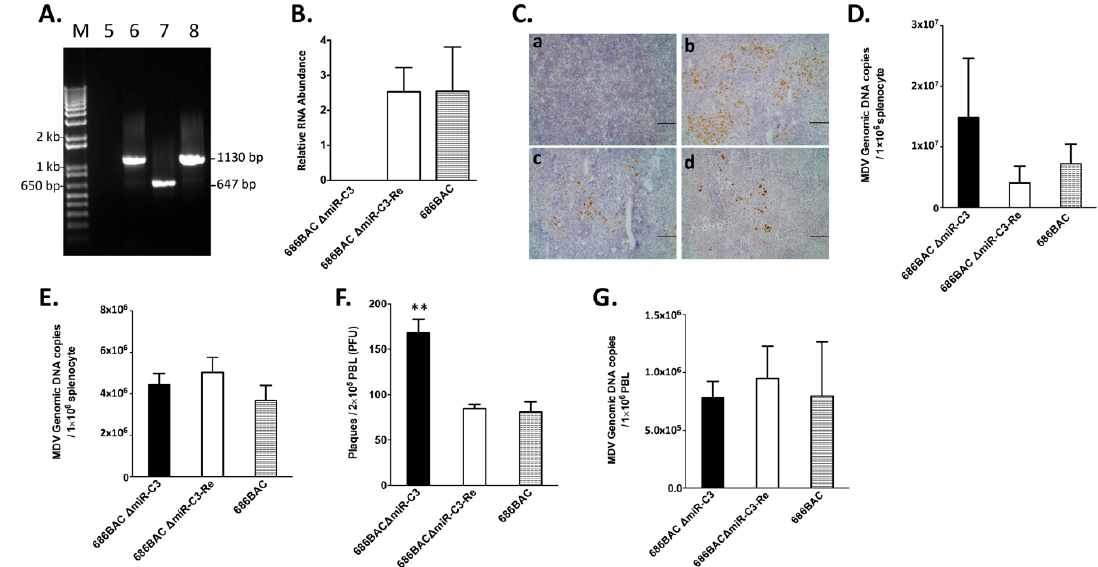
Figure 2. In vivo characterization of cluster 3 miRNA deletion and revertant viruses. One-day-old, specific pathogen-free chickens were inoculated with 2000 plaque-forming units (PFUs) of parental 686BAC, mutant 686BAC ∆ miR-C3, or revertant 686BAC ∆ miR-C3-Re. One group of chickens was not inoculated and served as a negative control. ( A ) PCR analysis of parental 686BAC, mutant 686BAC ∆ miR-C3, and revertant 686BAC ∆ miR-C3-Re genome. At 5 days post-inoculation (dpi), genomic DNA isolated from the peripheral blood lymphocytes (PBLs) of uninoculated or virus-infected